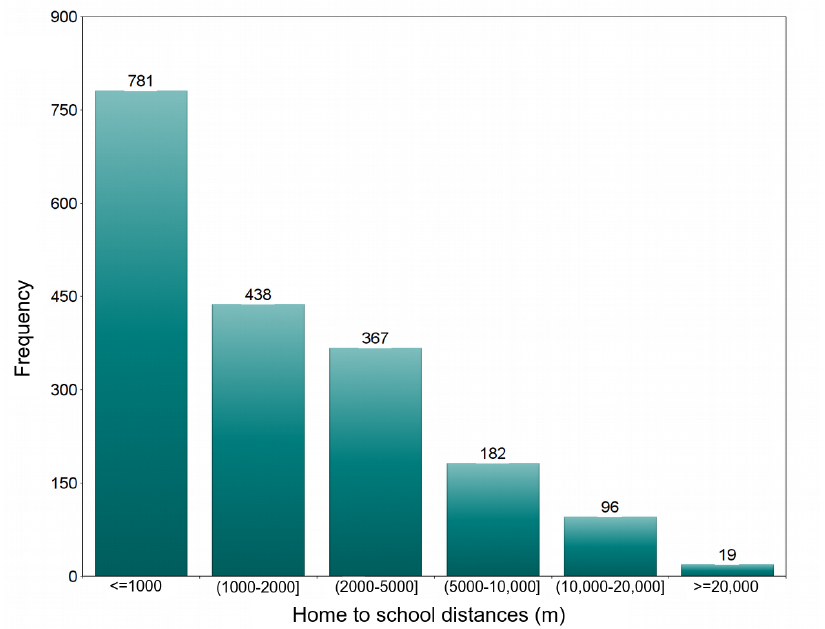
Figure 10. Number of homes located in each of the zones within the distance of the